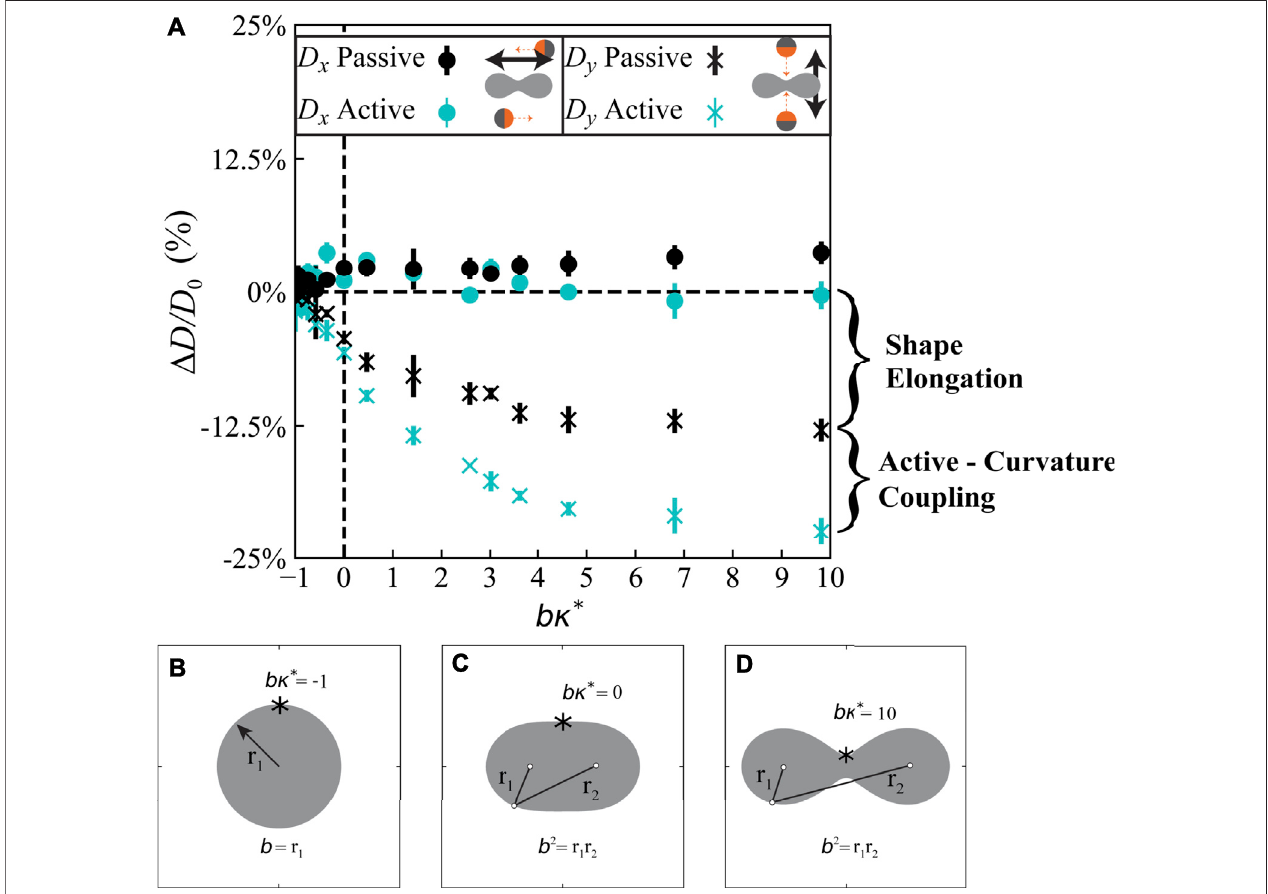
FIGURE5 | Curved obstacles with alargeconcavitygeneratea signi fi cantslowdown in diffusive transport of active particles compared topurely convex shapes at the same packing fraction. (A) Scaled diffusivity deviation as a function of shape concavity for the Cassini Oval shape described by Eq. 3 , where b κ * is the non- dimensional curvature at the top of the inclusion. The diffusivity along the direction facing the concavity, D y , decreases by 24% for the active particles for highly concave obstaclescomparedto12.5%forthepassiveBrownianparticles,indicatingthatthecouplingbetweentheactiveforceandcurvatureplaysakeyrole.Totalpacking fraction is fi xed at ϕ ≈ 5.5 % , and error bars are the standard deviation of three independent trials. (B – D) : Schematics of area preserving Cassini Ovals for three different parameter sets. The two foci are separated a distance of 2 a . Beyond a critical distance, a (cid:1) b /